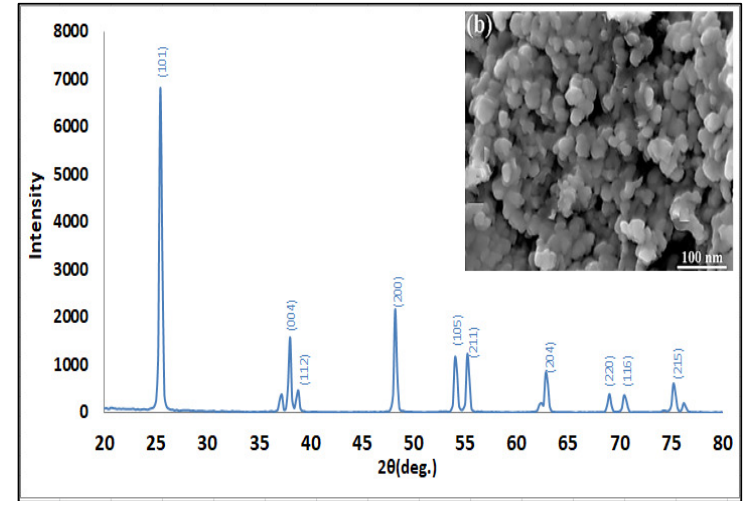
Fig. 2. XRD pattern (a) and FE-SEM (b) image of TiO 2 nanoparticles.